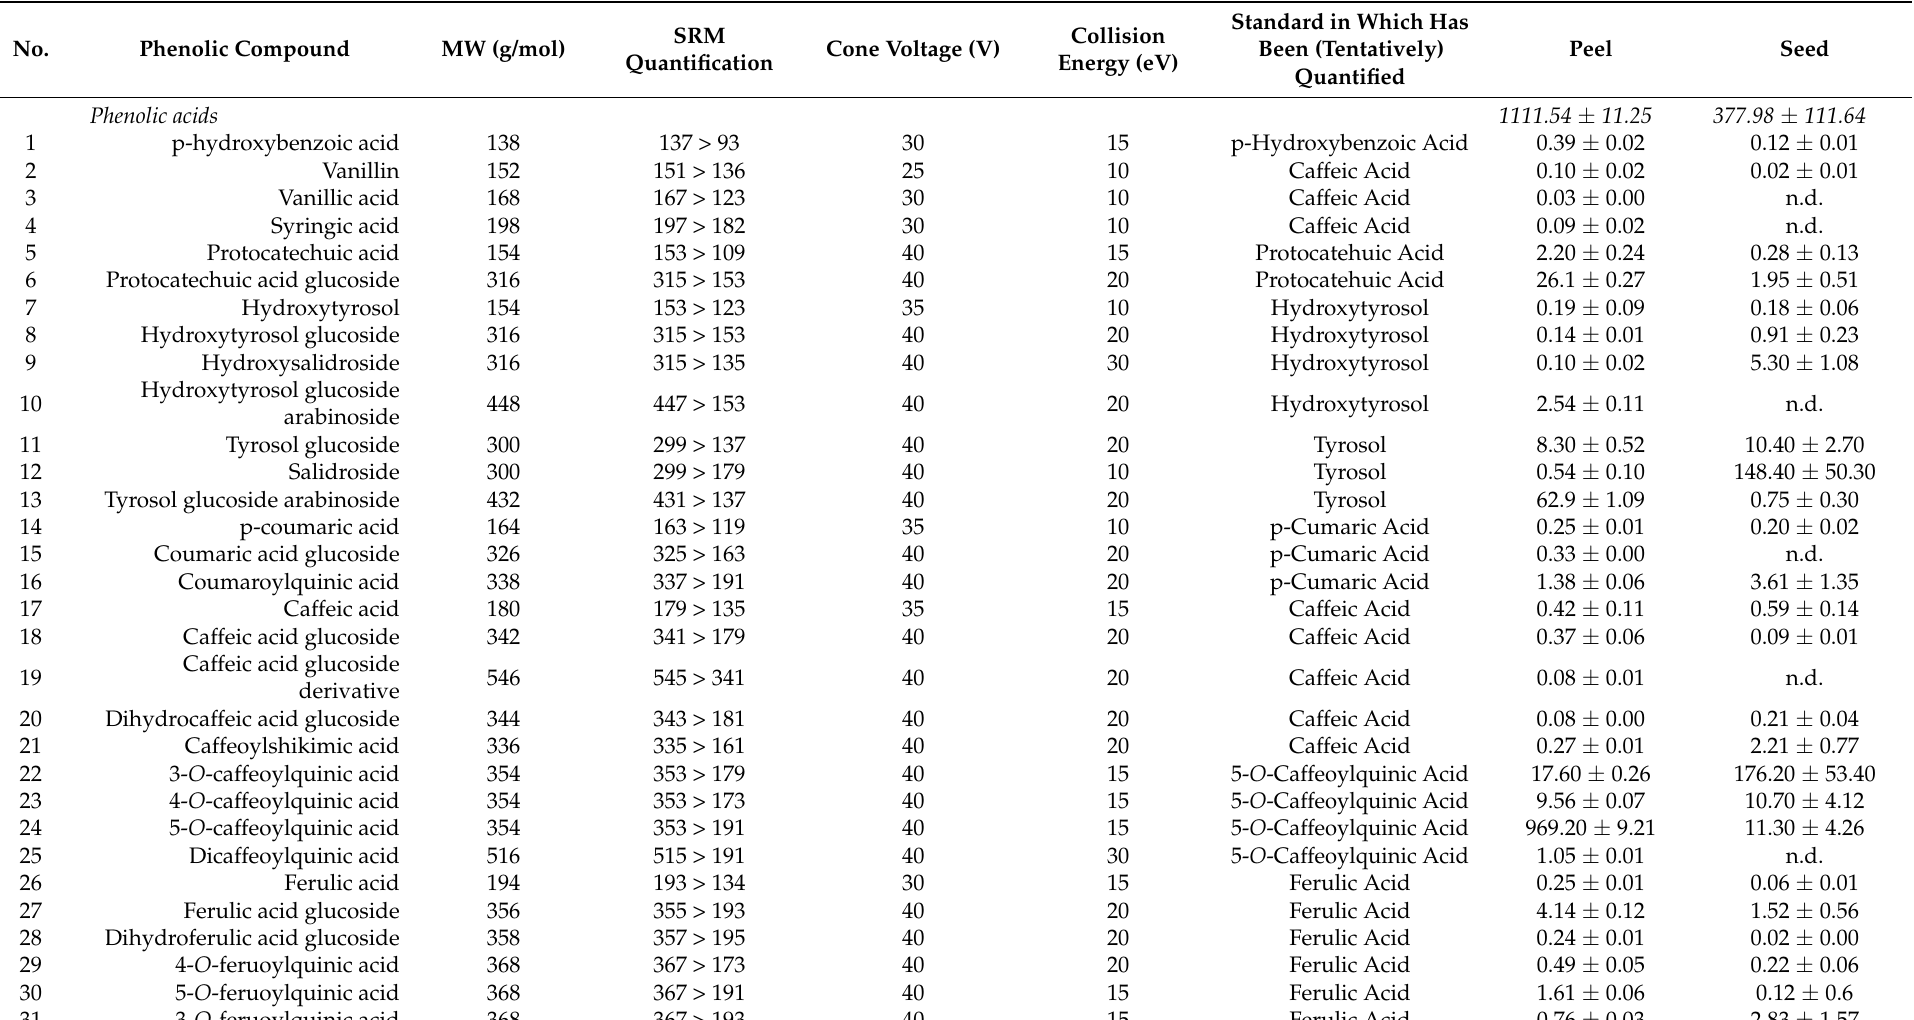
Table 2. Tentative quantification of phenolic compounds in the avocado peel and seed extracts by